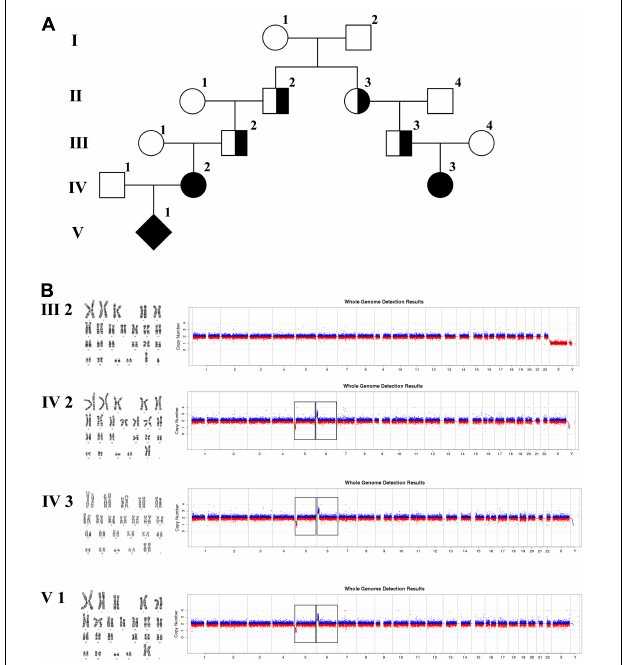
FIGURE 4 | Karyotyping and CNV-seq results of family 3. (A) The pedigree of the family 3. (B) Karyotyping and CNV-seq results. The box indicates the deletion of 5p and duplication of 6p in CNV-seq